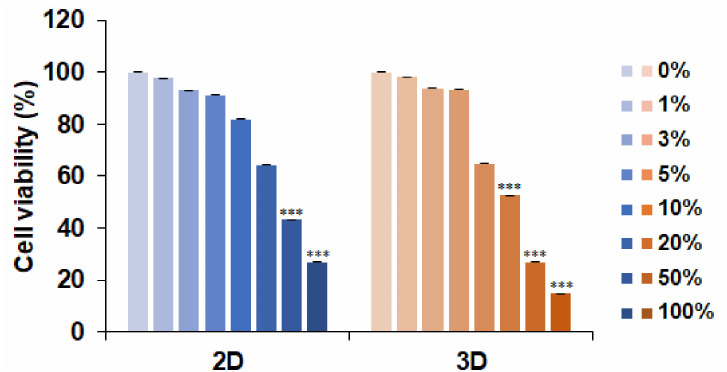
Figure 1. Antiproliferative e ff ects of L. fermentum Cell-Free Supernatants (LCFS) on 2D and 3D HCT-116 cells. Cell viability was determined using the MTS assay 72 h after treatment with LCFS ( n = 3, *** p ≤ 0.001).